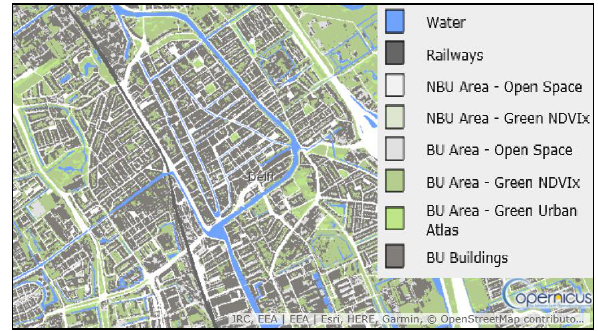
Figure 3. Example of European Settlement Map 2012 – Release